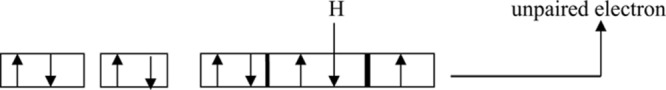
Hydroxyl radical (OH∙) as an example for ROS.